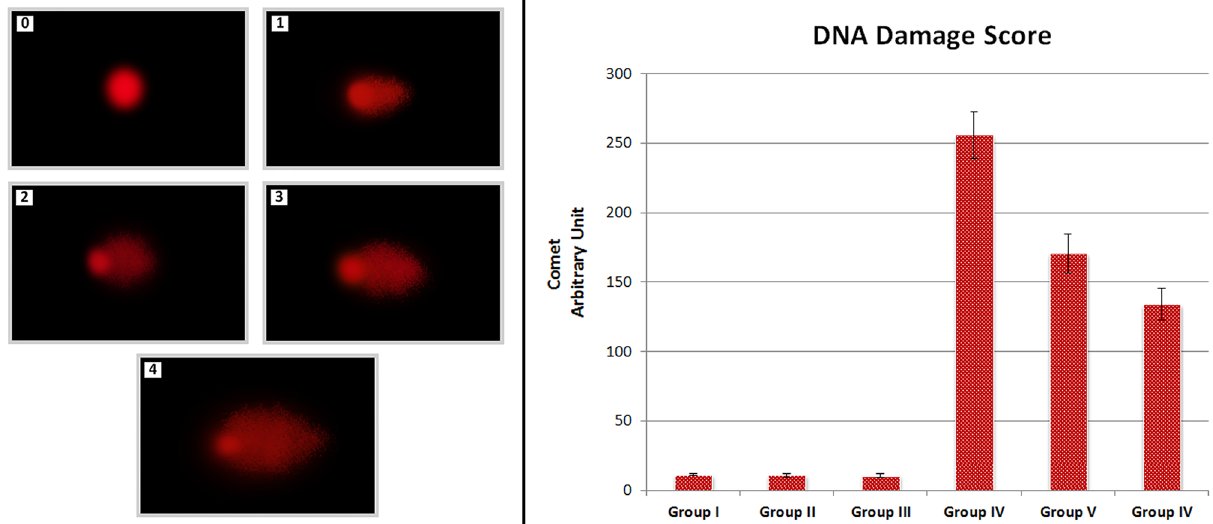
bw t-rsv, Group III: 20 mg/kg bw t-rsv, Group IV: 16 mg/kg bw AFM 1 , Group V: 16 mg/kg bw AFM 1 + 10 mg/kg bw t-rsv, Group VI: 16 mg/kg bw AFM 1 + 20 mg/kg bw